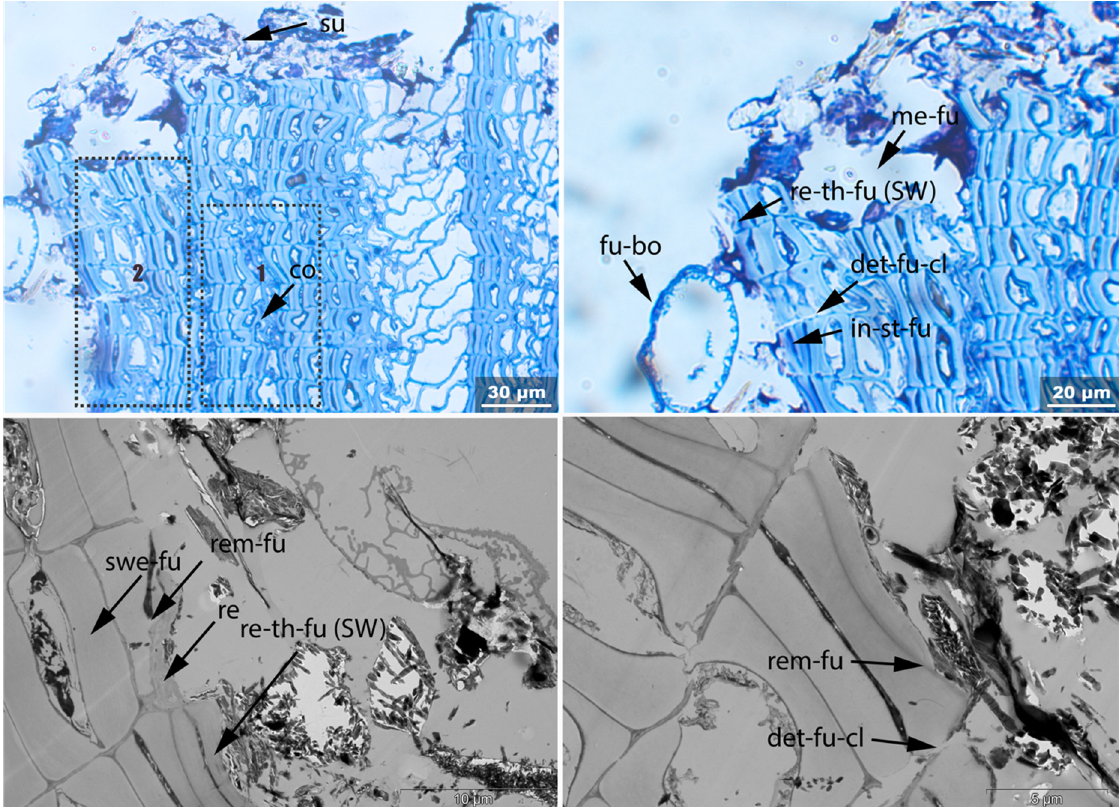
Figure 17. Sample 1. Top left: LM image of thin section. Area 1 has very well-preserved cell structure; area 2 is biodegraded. Superficial deposits are visible (su). In area 1, thin-walled cells are still compressed (co) and secondary cell wall layer of thick-walled cells is still birefringent (not shown). In area 2, clear change is noticeable in secondary cell wall layer: dark blue staining (in-st-fu), swelling (swe-fu) and dissolution of the wall (re-th-fu). Middle lamella (rem-fu) is also degraded (rem-fu), eventually leading to radial detachment of cells (det-fu-cl) (top right). Cavity in upper area (top right) between superficial and cell structure can be seen, in which complete cell structure dissolution occurred (me-fu). Changes to cell walls can be seen in more detail in TEM: thick-walled suberised cell walls are clearly swollen and loosened (swe-fu), after which they lose thickness (re-th-fu, SW)), leaving unstructured residue (re). Phenolic content of cell lumen is also degraded (rem-fu) (bottom left). Alterations of compound middle lamella can be seen at bottom left; wall loses thickness and electron density area is reduced